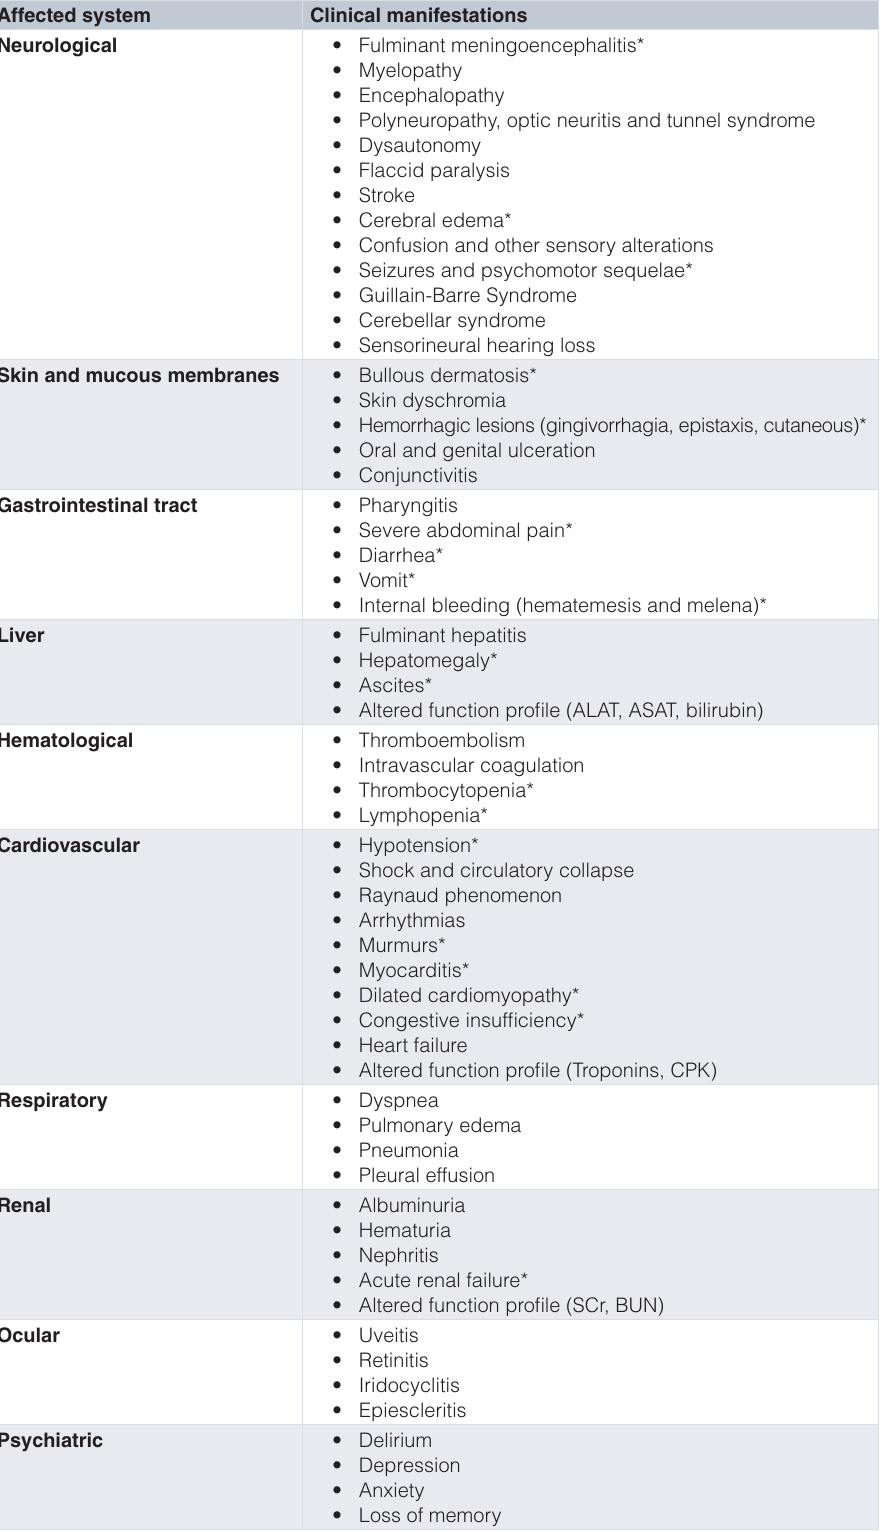
Table 2. Systemic extra-articular involvement of atypical CHIKV presentation 1,3,6,9–11,15,16,23–29 . ALAT: Alanine-aminotranspherase, ASAT: Aspartate-aminotranspherate, CPK: Creatine-phosphokinase, SCr: serum creatinine, BUN: Blood Urea